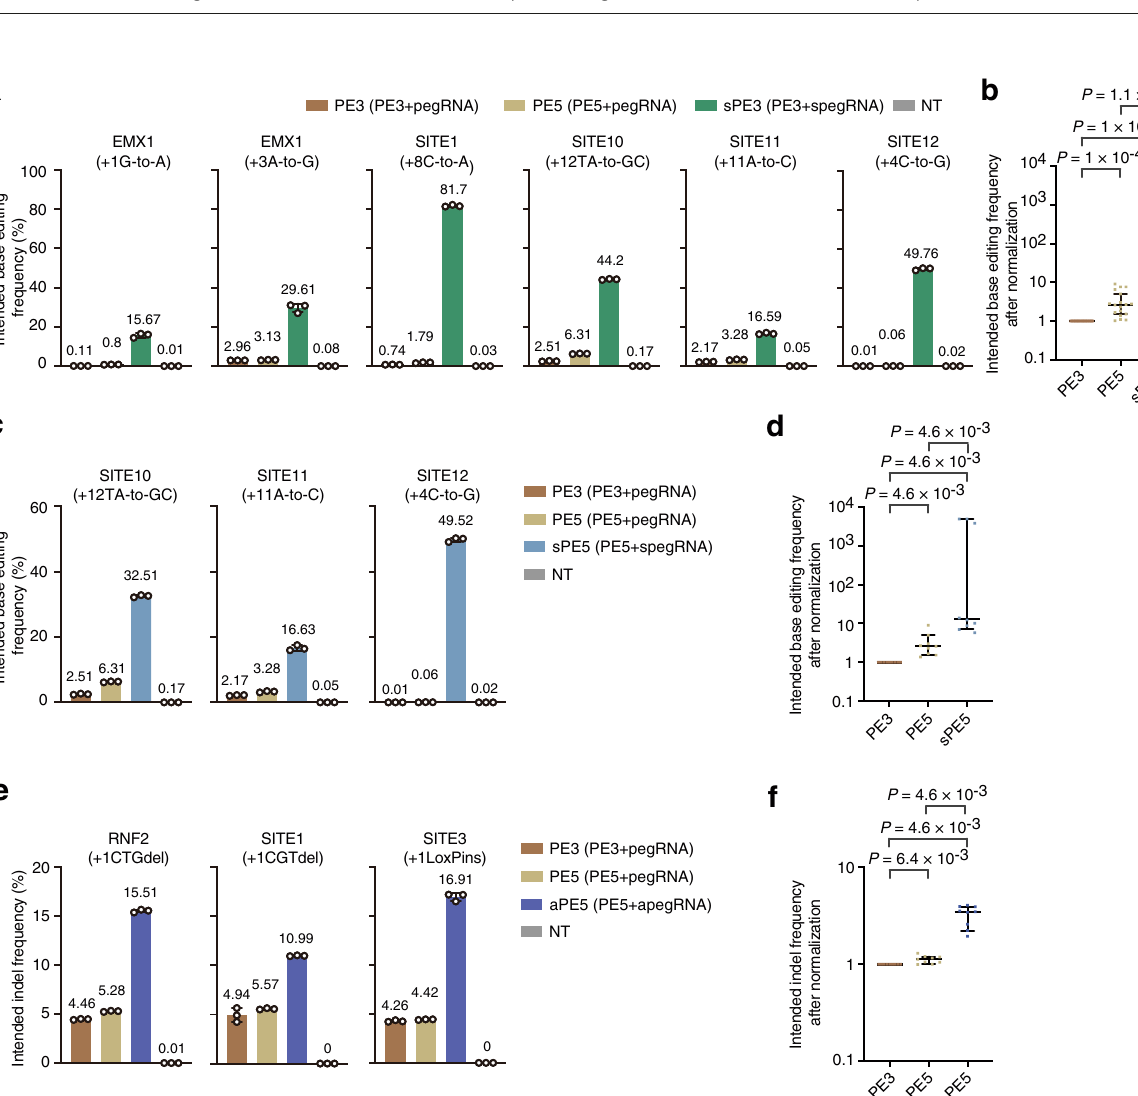
Fig. 2 pegRNA with a stabilized secondary structure induced higher ef fi ciencies of intended indel and single-base editing. a Schematic diagrams illustrating the predicted secondary structures of regular pegRNA and apegRNA-2. Presumably, the free swinging of the RTT and PBS can break up the small hairpin (left panel), which destabilizes pegRNA. However, engineering within the small hairpin of pegRNAs can stabilize the secondary structures of apegRNA-2 (right panel). b Intended indel frequencies were induced by pegRNA and apegRNA-2 at the indicated target sites under the PE3 setting or from non-transfected (NT) cells. c Statistical analyses of the intended indel frequencies and unintended indel frequencies after normalization, setting the frequencies induced by regular pegRNAs as 1. n = 117 editing from three independent experiments shown in b . d Intended single-base editing frequencies were induced by pegRNA and apegRNA without or with additional base substitutions at the indicated target sites under the PE3 setting. e Statistical analysis of normalized single base editing frequencies, setting the frequencies induced by regular pegRNAs as 1. n = 18 editing from three independent experiments shown in d . f Intended indel frequencies were induced by apegRNA and aspegRNA (with additional base substitutions) at the indicated target sites under the PE3 setting. g Statistical analysis of normalized intended indel frequencies, setting the frequencies induced by apegRNA without additional base substitution as 1. n = 18 editing from three independent experiments shown in f . b , d , f Means ± s.d. are from three independent experiments. c , e , g P